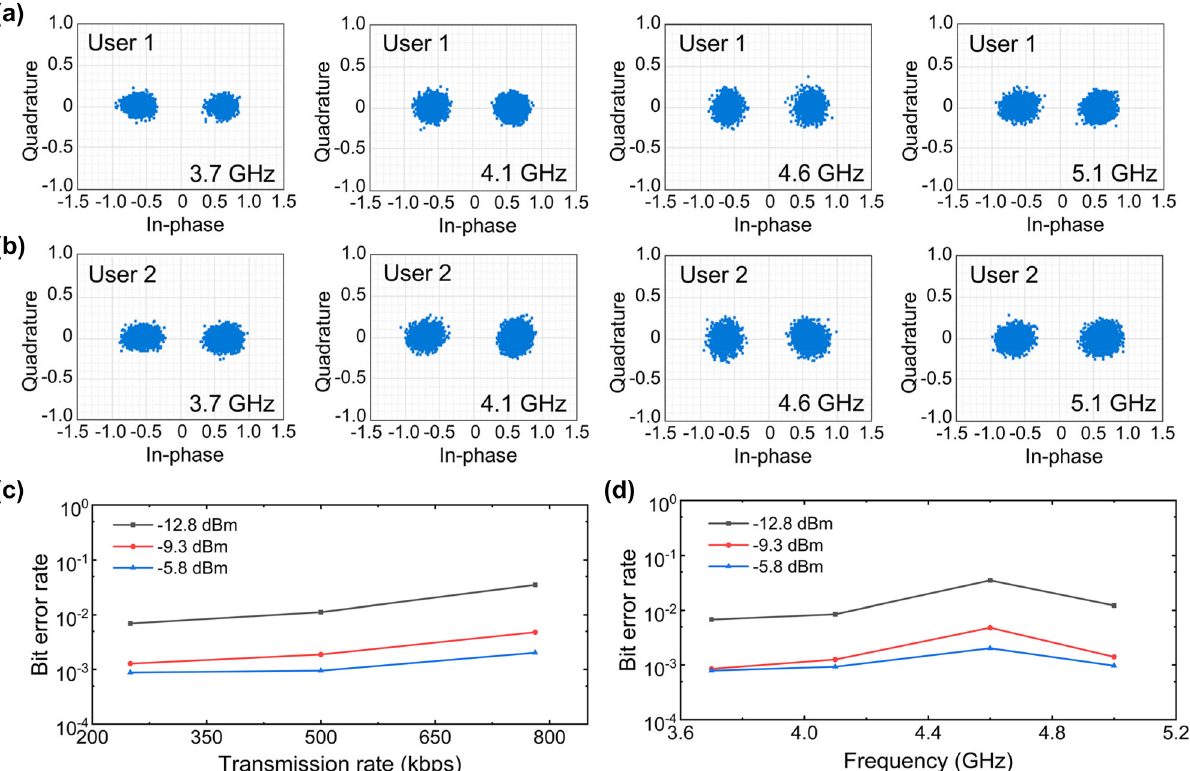
Figure 5: Measured constellation diagrams and BER performances with broadband characteristics. Measured constellation diagrams at (a) User 1, and (b) User 2 at 3.7 GHz, 4.1 GHz, 4.6 GHz, and 5.1 GHz. Measured BER performance (c) as a function of transmitting power and transmission rate at 4.6 GHz, and (d) as a function of transmitting power and operation frequency at maximum transmission rate of 781.25